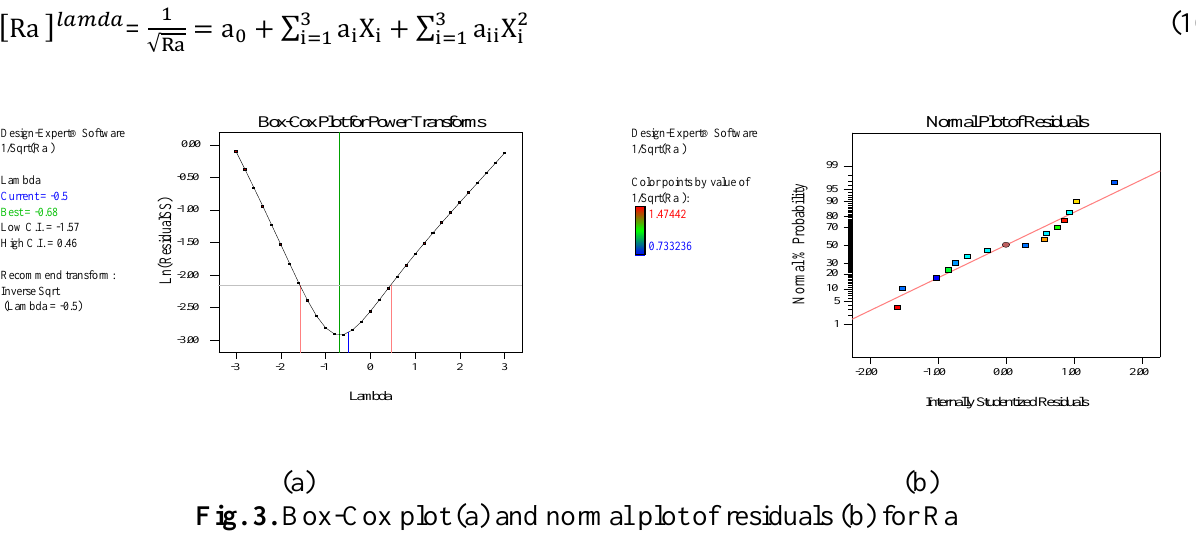
Fig. 3. Box-Cox plot (a) and normal plot of residuals (b) for